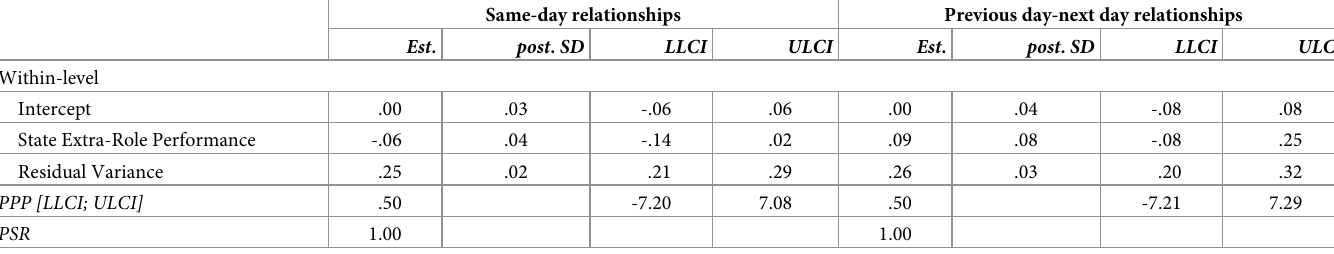
Table 2. Multilevel Structural Equation Models predicting state eudaimonic well-being from state extra-role